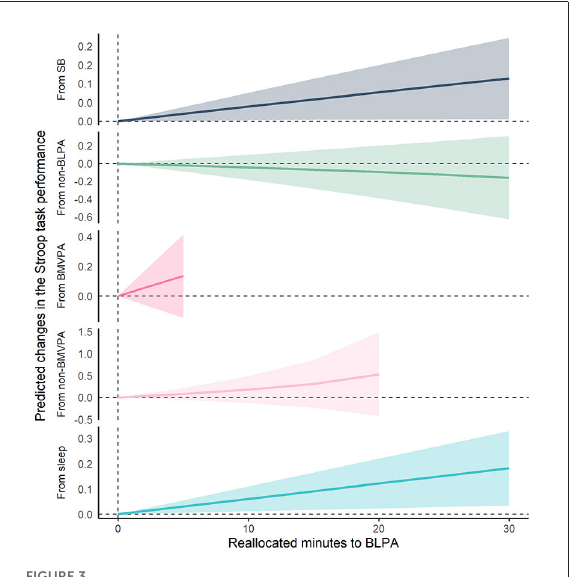
FIGURE2 Differences in predicted changes of Stroop task performance when fixed amounts of time were reallocated from one movement behavior to LPA while keeping the remaining components constant at compositional means. The analysis was based on Model 2. SB, sedentary behavior; LPA, light-intensity physical activity; MVPA, moderate- to vigorous-intensity physical activity.